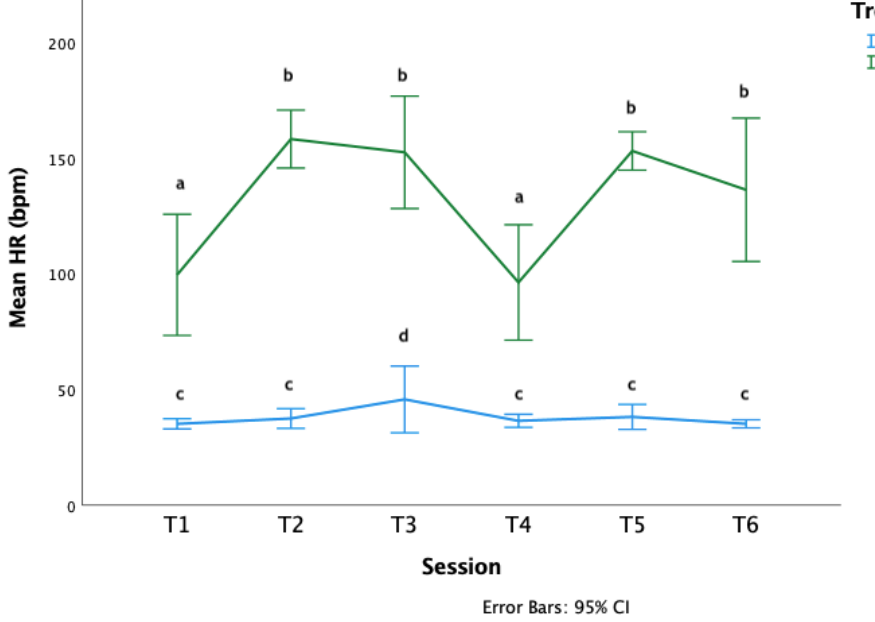
Figure 5. Mean heart rates (bpm) during the six treatment sessions. Letters which differ, differ significantly at p < 0.0001.